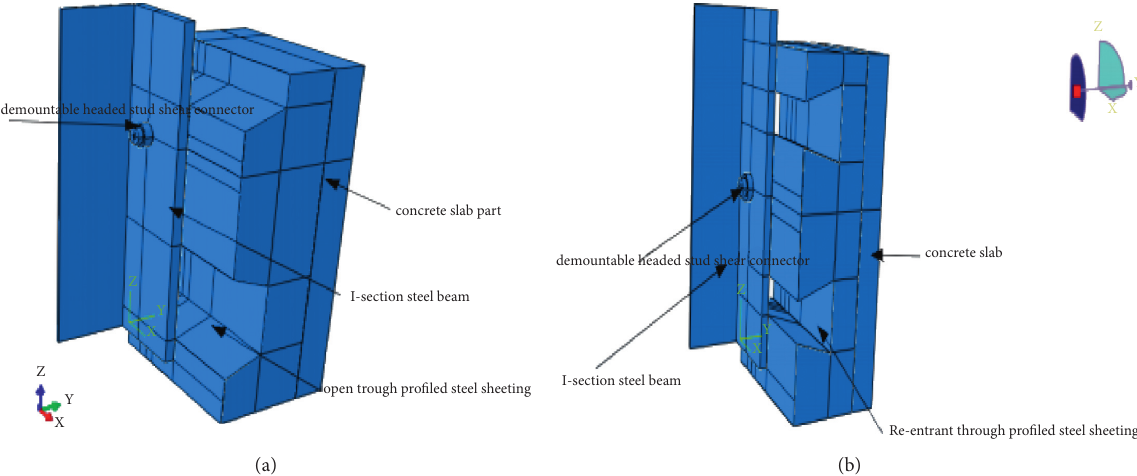
Figure 4: Assembled model with (a) open through and (b) reentrant profiled steel sheeting.